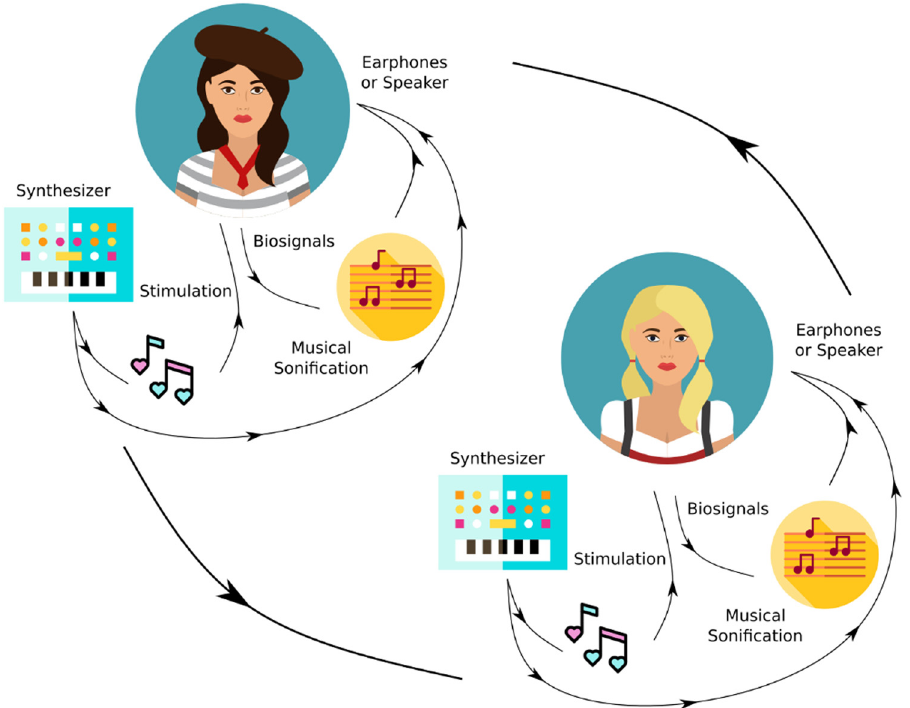
Figure 4: The use of PLAY ME in long - distance